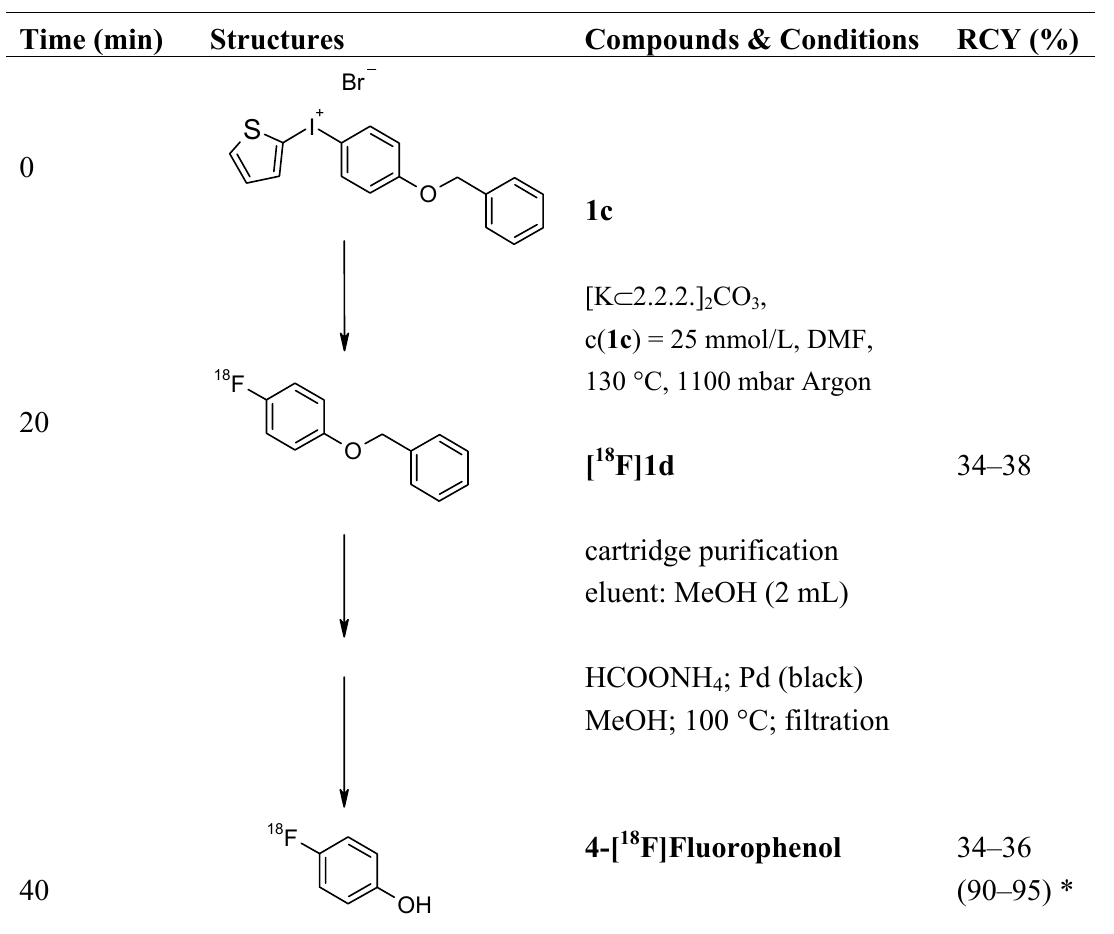
Table 1. Synthetic sequence of the two step radiosynthesis of n.c.a 4-[ 18